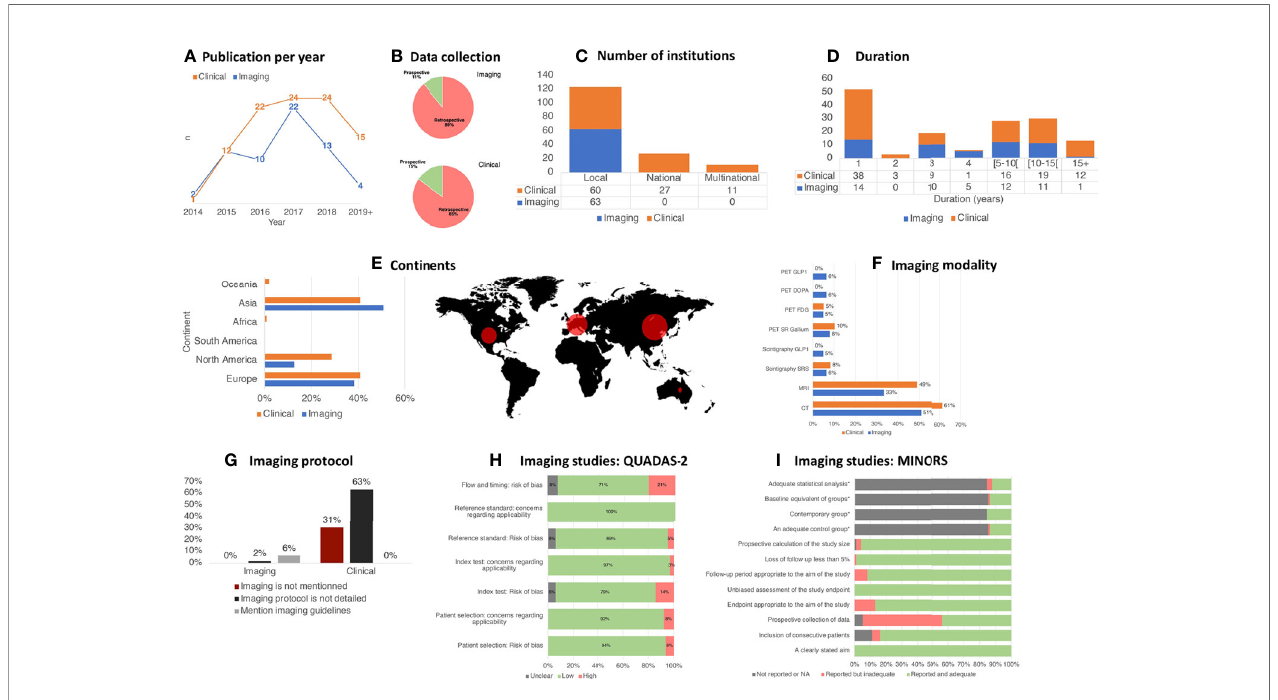
FIGURE 2 | Overview of trends in imaging practices for